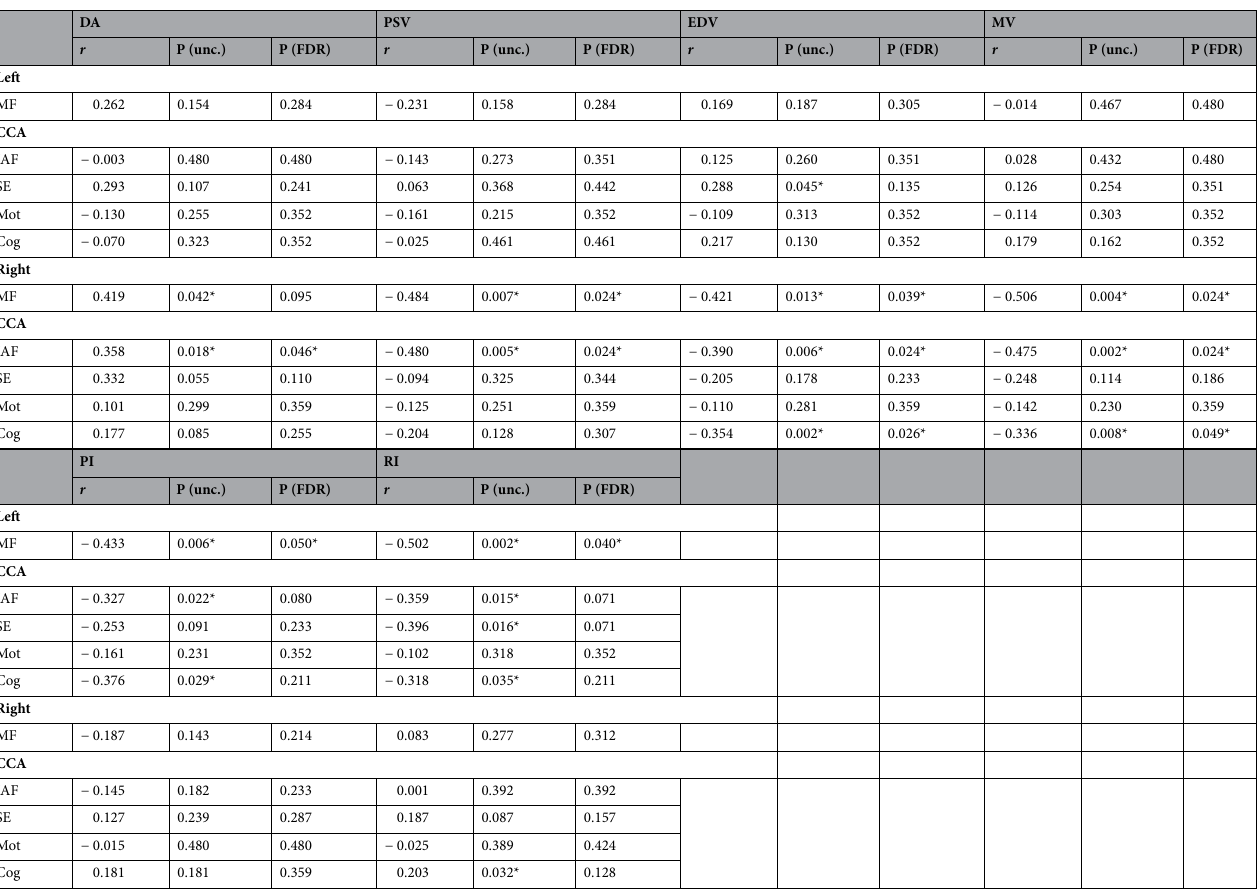
Table 2. Correlation matrix between sided ultrasonographic parameters, MEG spectral parameters, and FIM. CCA common carotid arteries, Cog . cognitive-FIM score, FIM functional independent measurement,